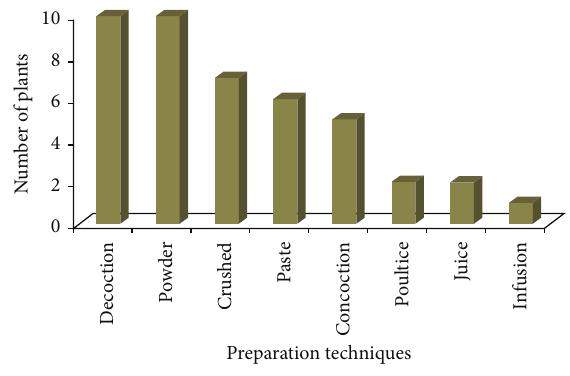
Figure 3: Traditional medicines